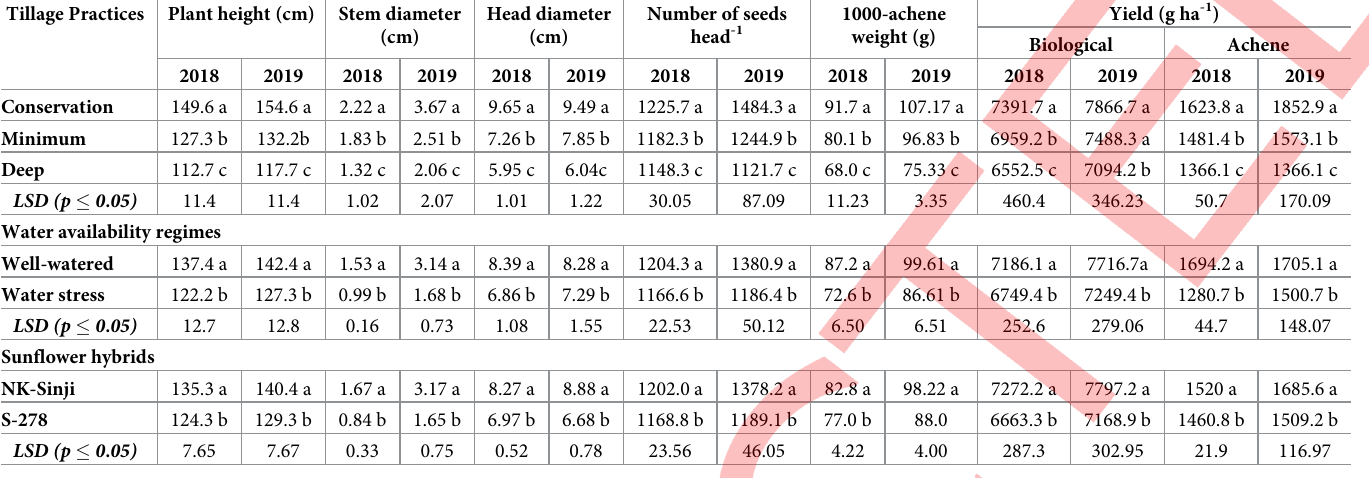
Table 2. The impact of different tillage practices and water availability regimes on morphological and yield-related related traits of sunflower hybrid type in 2018 and 2019. Tillage Practices Plant height (cm) Stem diameter